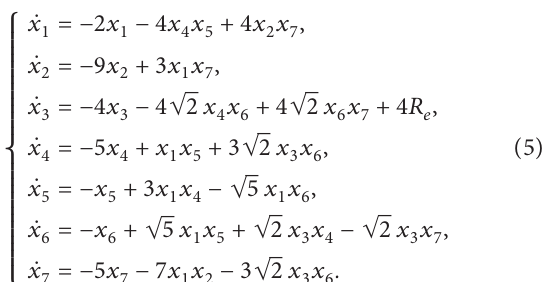
Figure 1: Phase portrait of the four asymptotically stable fixed point at R e �